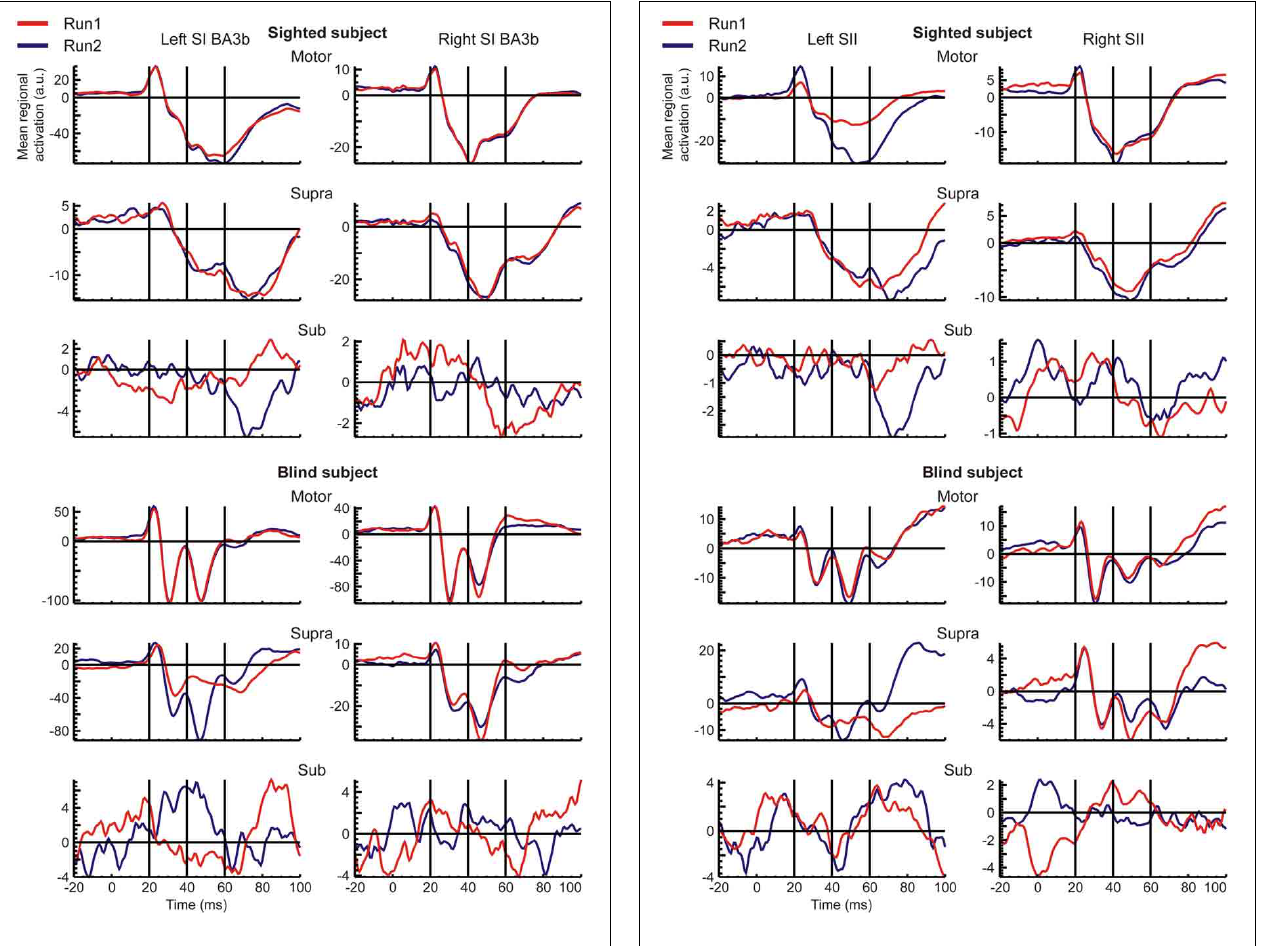
FIGURE 2 | Mean regional activation curves (RAC) of left (left column) and right (right column) S1 ROIs, generated in response to contralateral stimuli are shown for both runs (overplotted red and blue curves) of each stimulus intensity (indicated on top of each rows) in a sighted (upper half) and the blind (lower half) subjects.